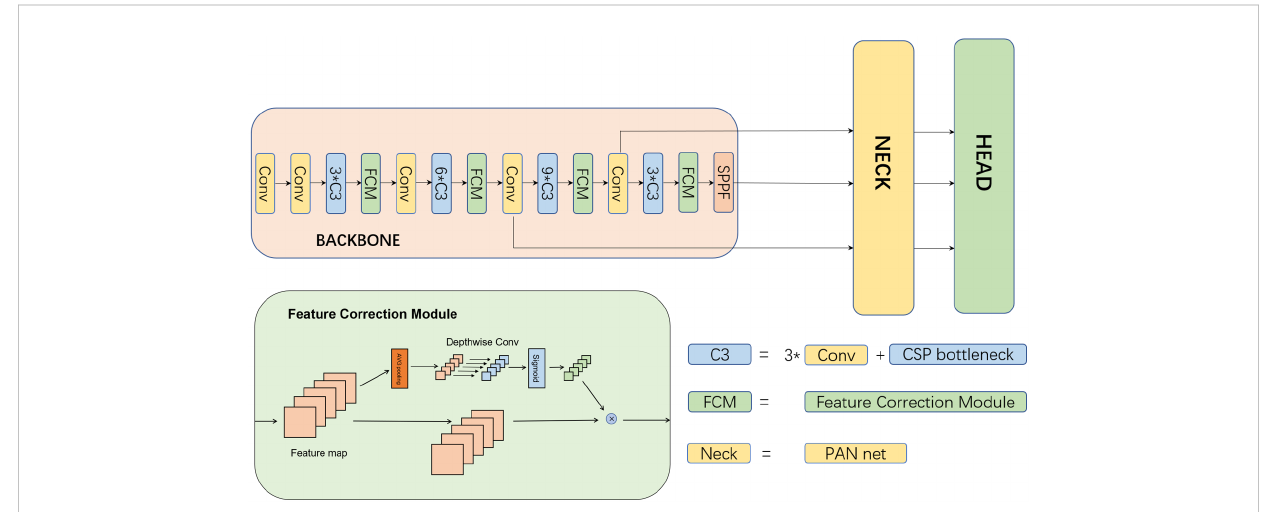
FIGURE 5 Our model structure and the speci fi c implementation of the feature correction